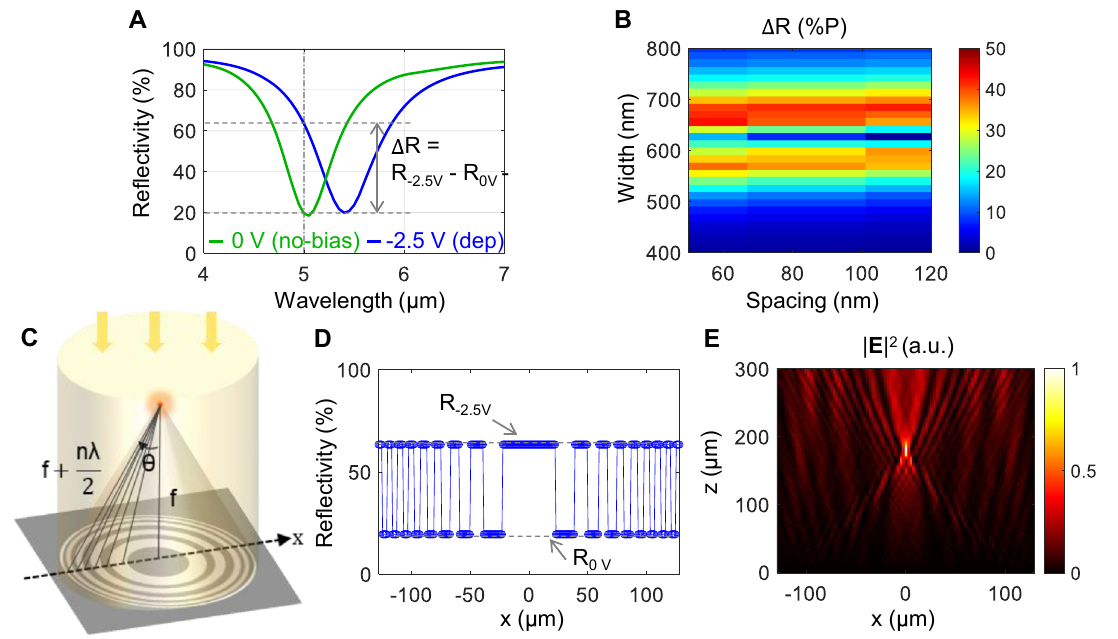
Figure 3: Amplitude modulation and beam focusing of mid-infrared light. (A) Reflectivity spectrum for different voltages of 0 V (the green line) for no-bias, and − 2.5 V (the blue line) for depletion. The contrast of the re fl ectivity underapplied biases denoted by Δ R is the maximumat the wavelength of 5.0 μ m denoted by the vertical dash-dottedline. (B) Map for the re fl ectivity contrast for different values of widths and spacings. (C) Schematic of the Fresnel Zone plate consisting of multiple co- centeredringswithalternatingintensity.(D)Re fl ectivitydistributionassignedtoeachAlantennatoimplementtheFresnelZoneplatein(C)as an example of beam focusing with the focal length of 200 μ m according to (2). (E) Electric fi eld intensity distribution calculated by using the one-dimensional variation of the re fl ectivity given in (D), indicating that the focus is formed at the designed focal length of 200 μ